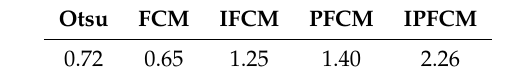
Table 5. Average computation time for various techniques in seconds.